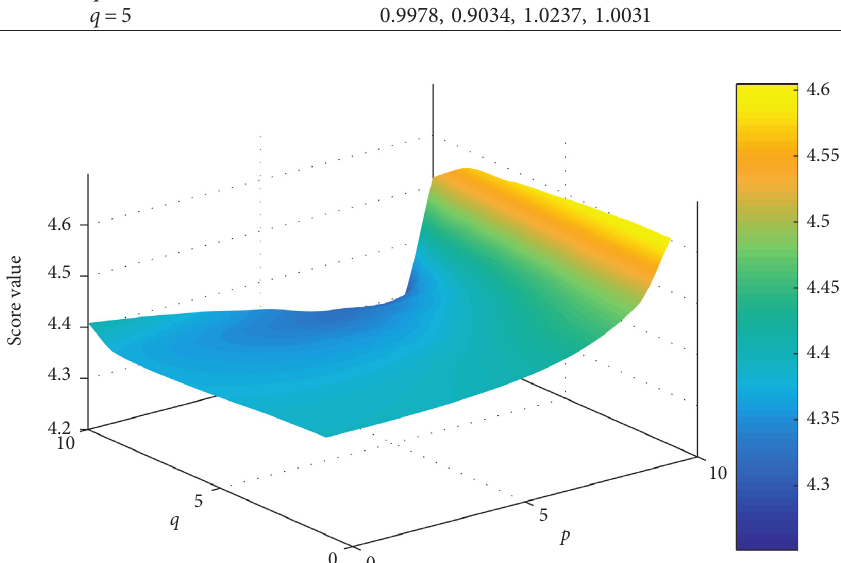
when p,q ∈ [ 0 , 10 ]( θ � 5 ) 1